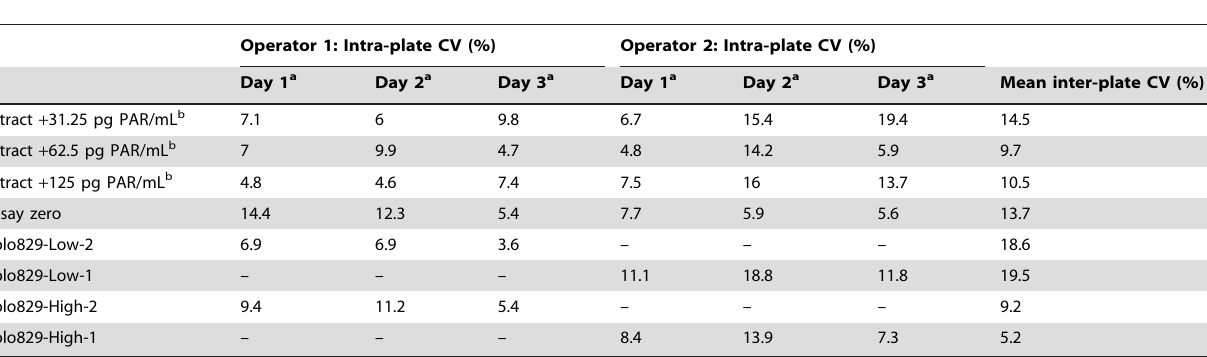
Abbreviation: CV, coefficient of variation. a Assays performed on 3 non-consecutive days.